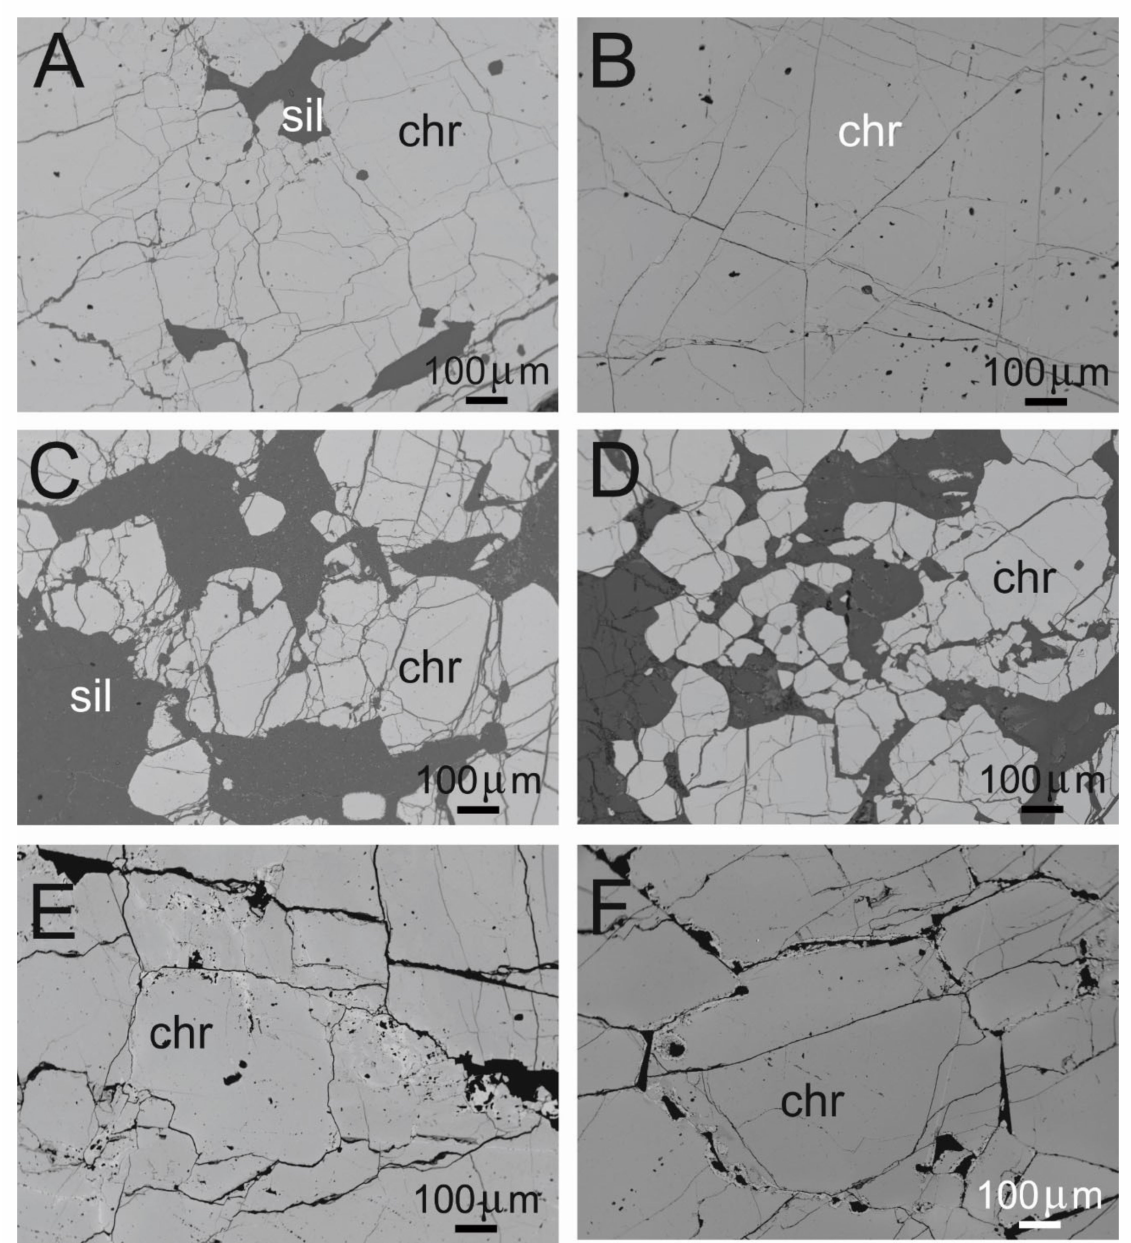
Figure 4. Back scattered electron (BSE) images of the chromite texture. Massive chromitite composed of closely interlocked chromite crystals cut by cracks and fissures, and spotted with silicate patches larger than 100 µ m, and minute silicate inclusions ( A , B ). Networked chromitite containing up to 10–30% interstitial silicate ( C , D ). Chromite showing incipient alteration into ferrian-chromite along grain boundaries and cracks ( E , F ). Bolshoi Bashart samples BB7619 ( A ), BB7616 ( C ), and BB7612 ( E ); Prospect 33 samples PE1757( B ), PE1758 ( D ), and PE1755 ( F